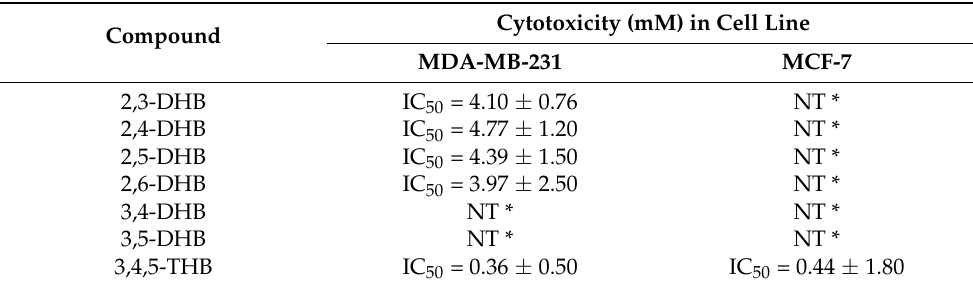
Table 5. IC 50 values for the tested hydroxybenzoic acids on breast cancer cells. Mean values from three independent experiments ± SD are shown. Cytotoxicity (mM) in Cell Line Compound MDA-MB-231 MCF-7 2,3-DHB IC 50 = 4.10 ± 0.76 NT * 2,4-DHB IC 50 = 4.77 ± 1.20 NT *